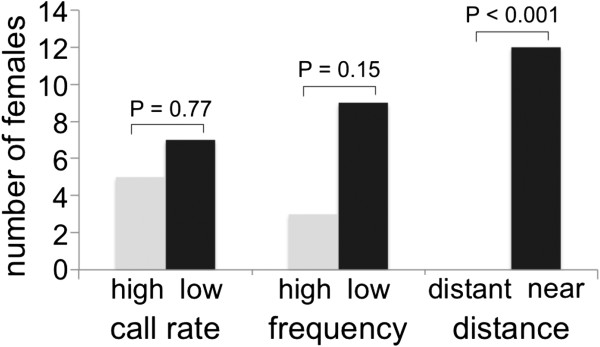
Playback experiments. Number of females choosing one of the two alternatives (high vs. low call rate, high vs. low frequency, distant vs. near speaker). A two-sided binomial test was used to test for female preferences.